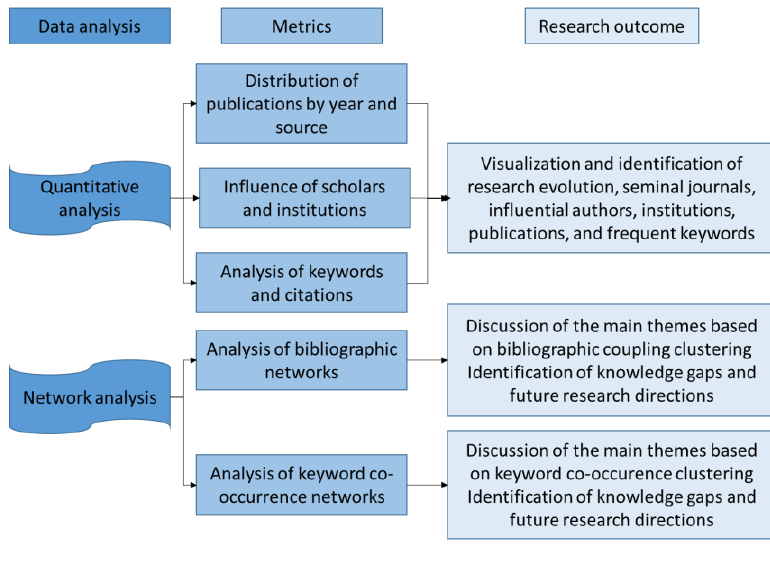
Figure 2. Research approach.